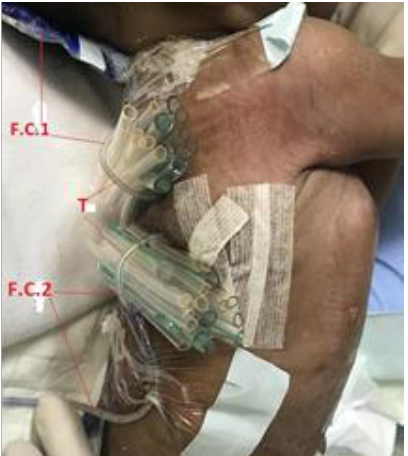
Figure 2: Showing the traction tubes under the exterior-